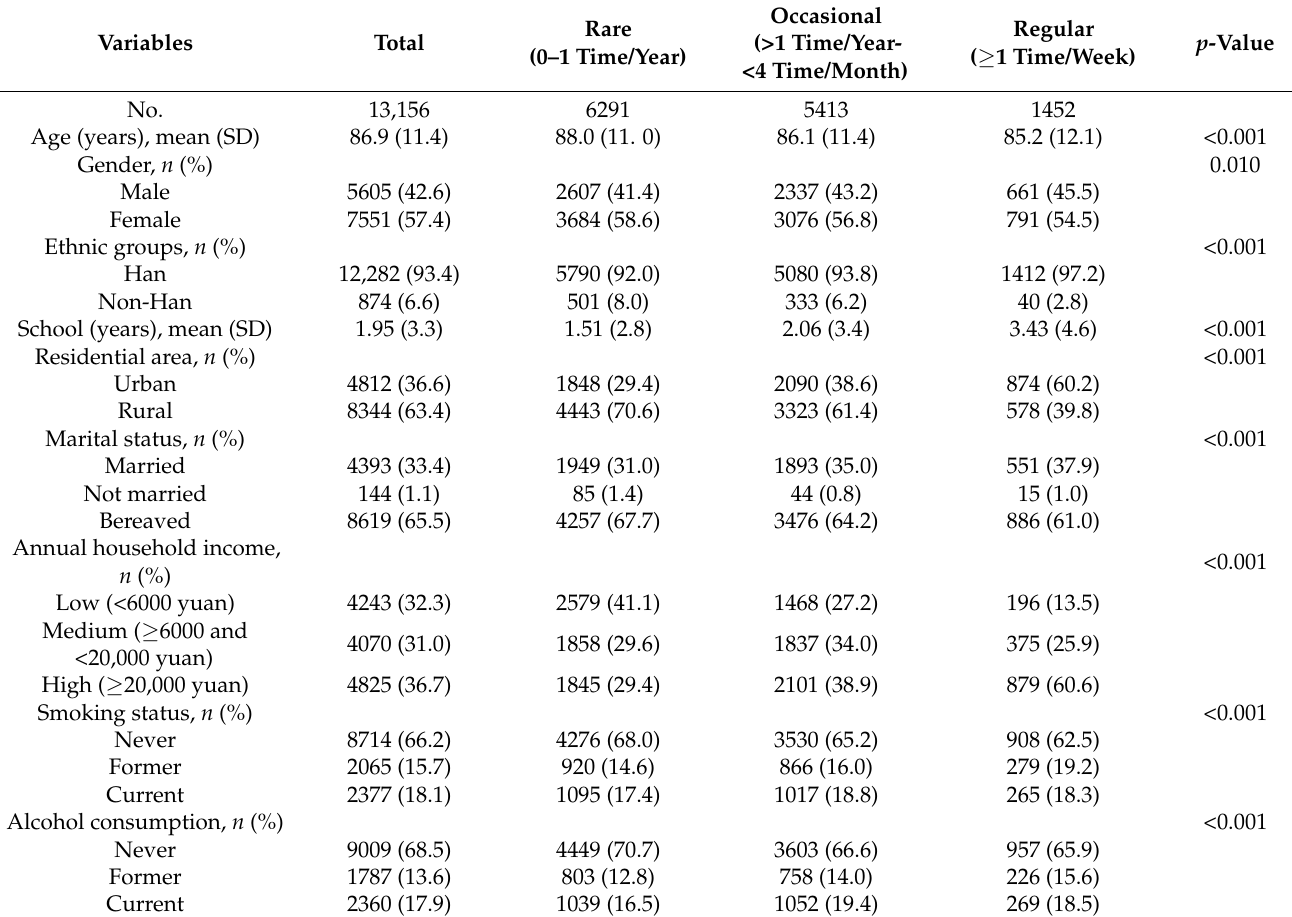
Table 1. Baseline characteristics of the study